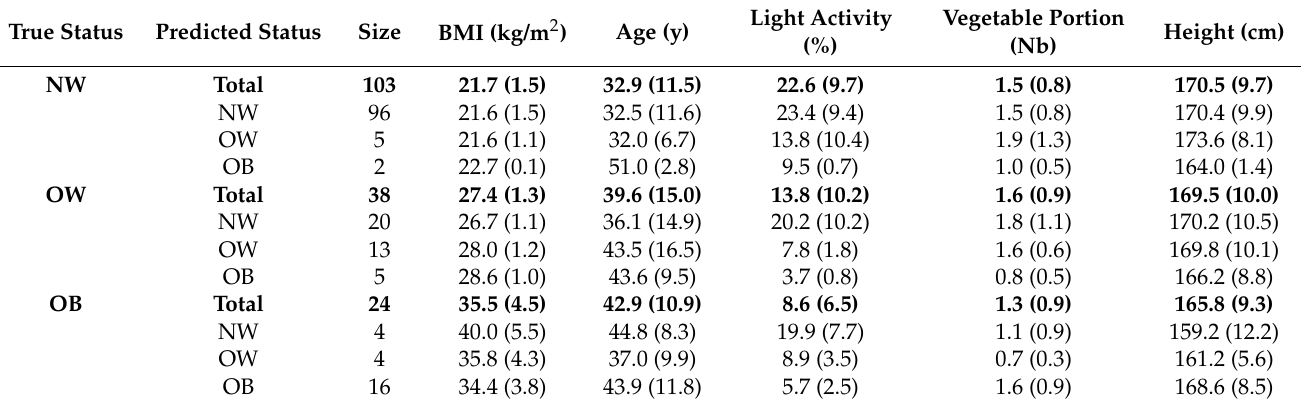
Table 5. Characteristics of true and false positives by weight status in the test sample (Mean (SD), n =